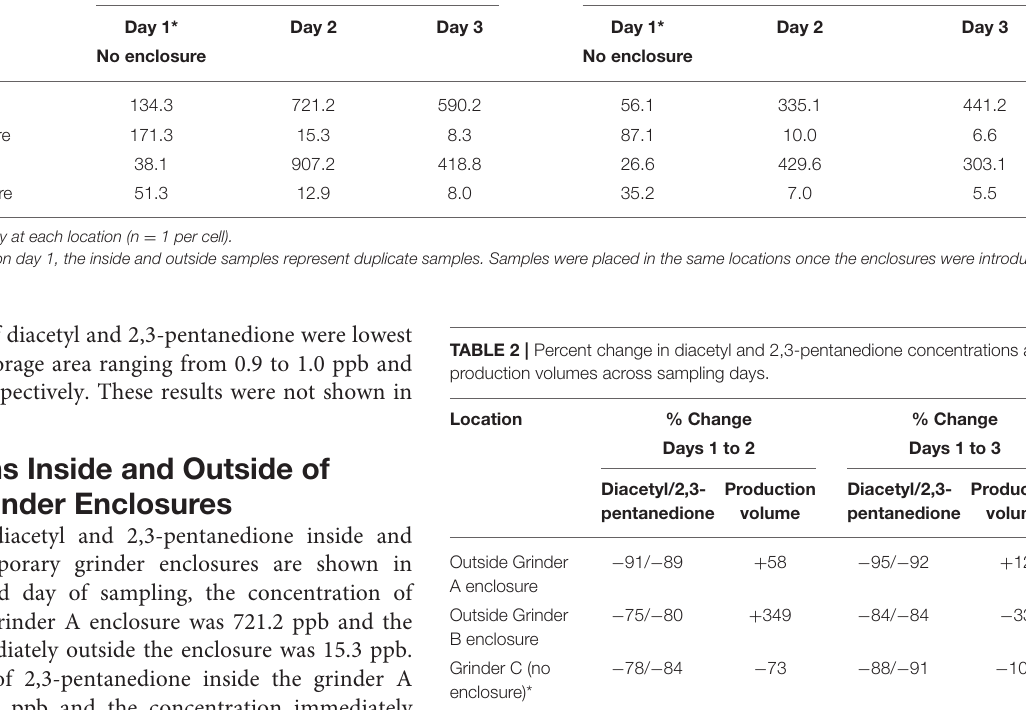
TABLE 1 | Diacetyl and 2,3-pentanedione concentrations in parts per billion (ppb) inside and outside Grinder A & B enclosures. Location